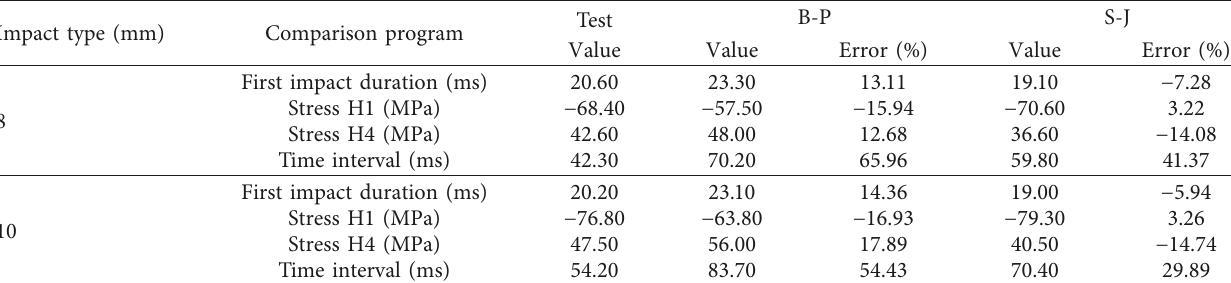
Table 3: Deviations between the numerical and test results with roof